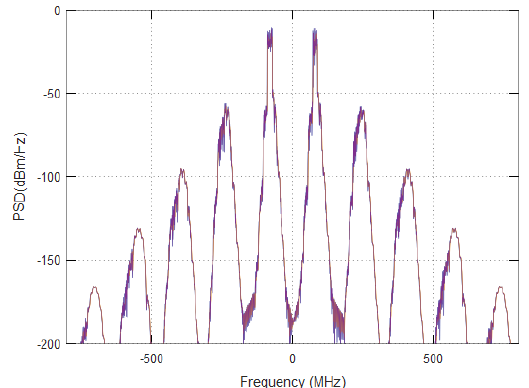
Figure 2. PSD of the output of nonlinearity for an input that consists of the sum of two OFDM signals with frequency separation of 100 MHz.